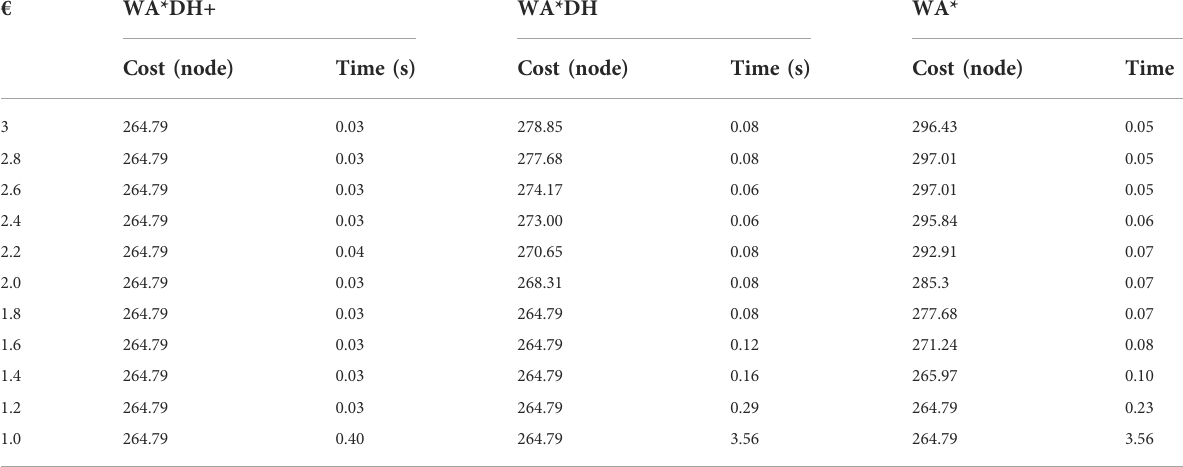
TABLE 4 Quantitative comparison of the performances of algorithms on simulation